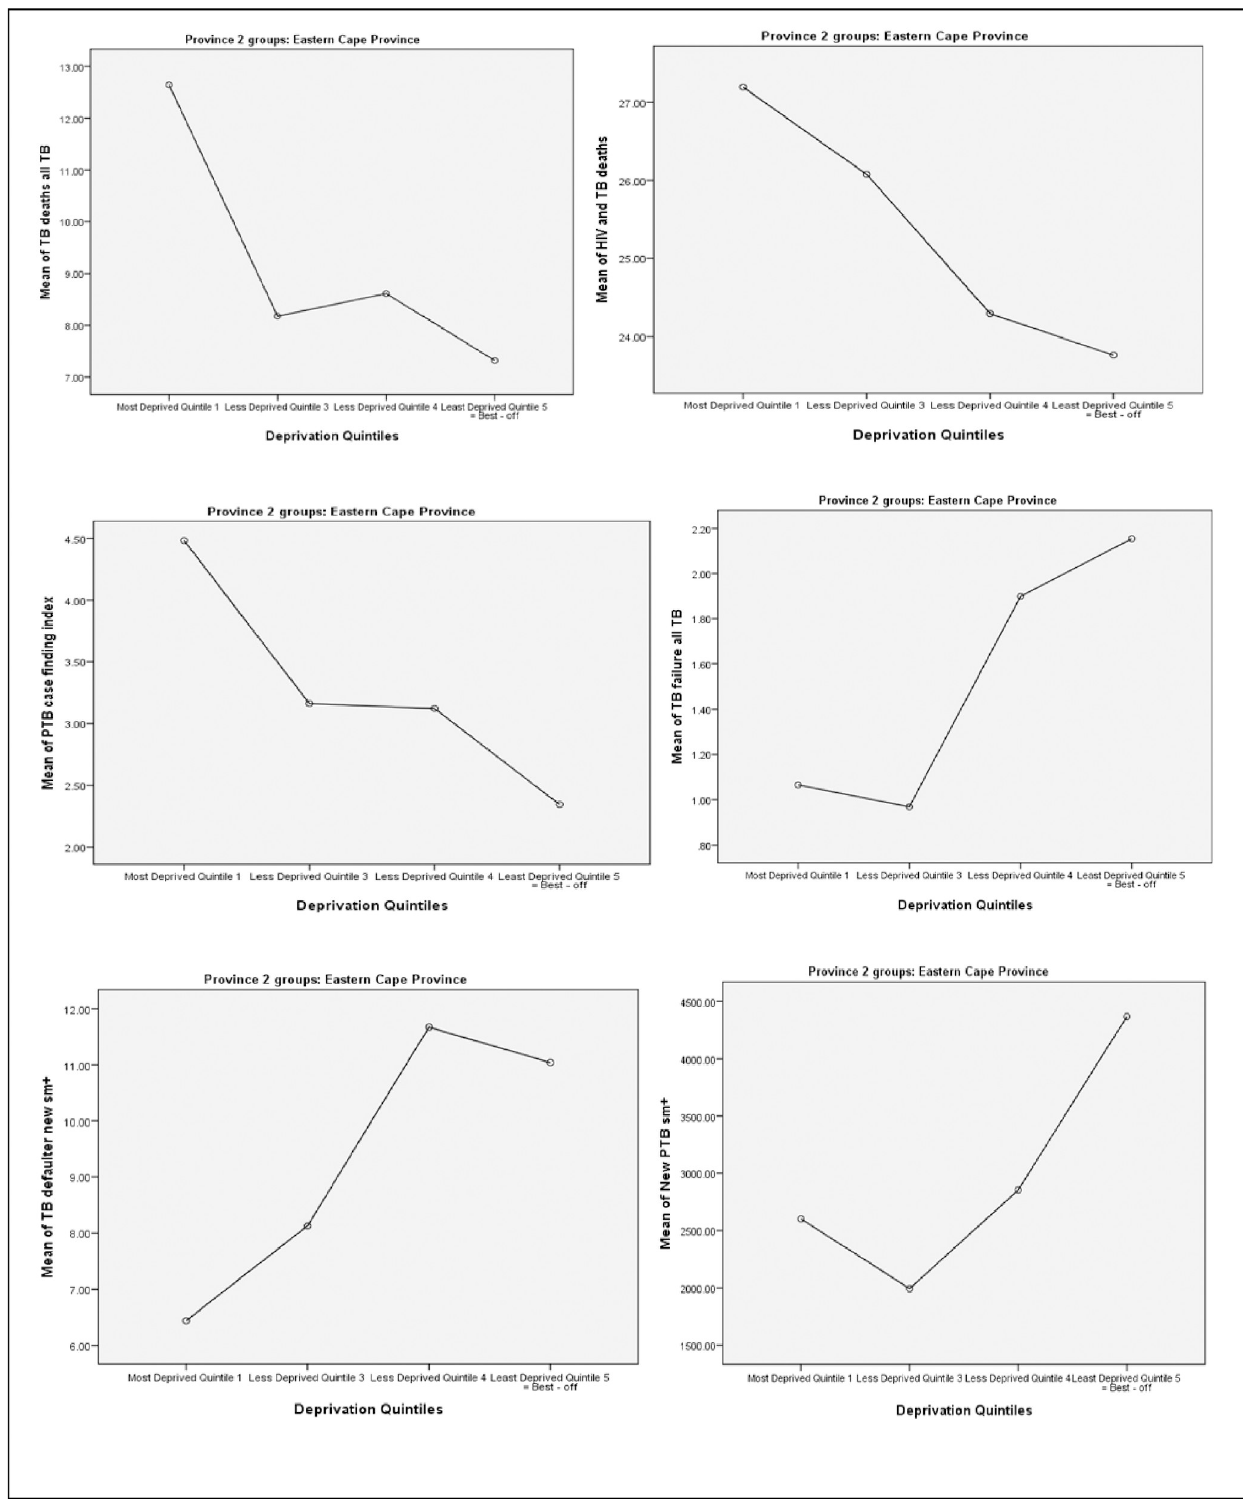
Fig 3. Associations between socio-economically deprived groups and TB care indicators in OR Tambo district over a 5-year period (2009–2013). A. Correlation between TB death rate and deprivation index (P < 0.0001). B. Correlation between HIV associated TB death rate and deprivation index (P = 0.049). C. Correlation between TB rate among household contacts of index TB cases and deprivation index (P < 0.0001). E. Correlation between TB